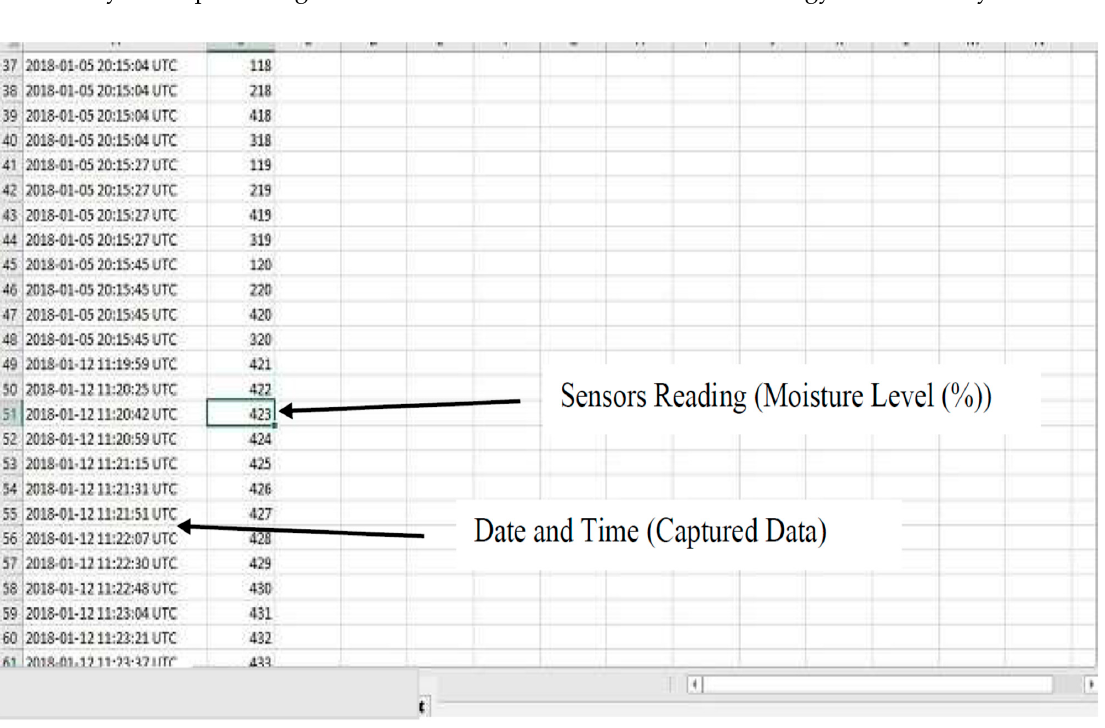
Figure 13. Sensor data logging.